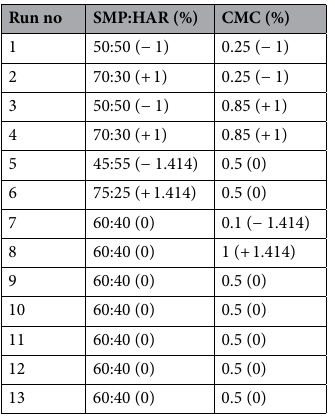
Table 1. Experimental ranges and coded levels of the independent variables generated using central composite rotatable design. Coded values are in parenthesis. SMP skimmed milk powder, HAR high amylose rice flour, CMC carboxymethyl